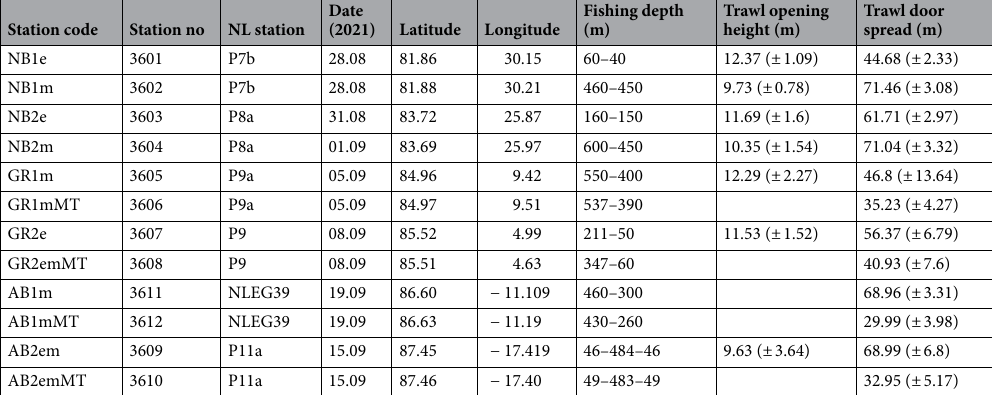
Table 1. Sampling effort with the trawls in the Arctic Basins. Sampling information includes fish station code, station number, Nansen Legacy project station name, date, location, fishing depth, mean and standard deviation for opening height (m) and door spread (m). Station code includes labelling for areas where samples were taken: Nansen Basin (NB), Gakkel Ridge (GR) and Amundsen Basin (AB). The station code also includes a notation denoting the depth of the trawl (e, epipelagic; m, mesopelagic, and em, both layers). The trawls denoted with MT were macroplankton trawls, while the others were Harstad trawls. Additional information, including on the acoustic stations and the CTDs, can be found in Table S1.